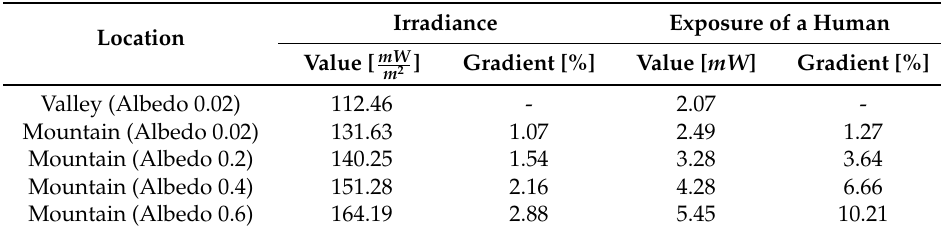
Table 1. Simulated values of the irradiance and the human exposure for the valley and mountain location are shown. Additionally, the gradients of the increase with altitude of the simulated values were calculated with Equation (4), where ∆ altitude = 1600 m was used. The influence of the albedo is larger for the exposure of a human than for the irradiance.